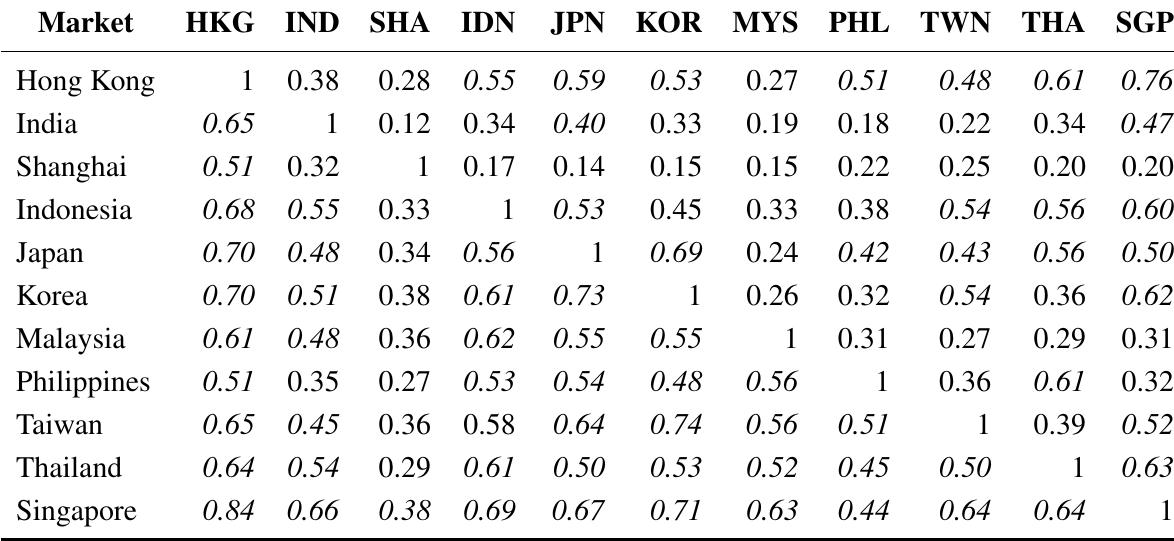
Note: The table shows the correlation matrix for the daily stock index retuns in levels (lower left triangle) and for the squared returns (upper right triangle). Values in italic face represent correlation coefficients greater than or equal to